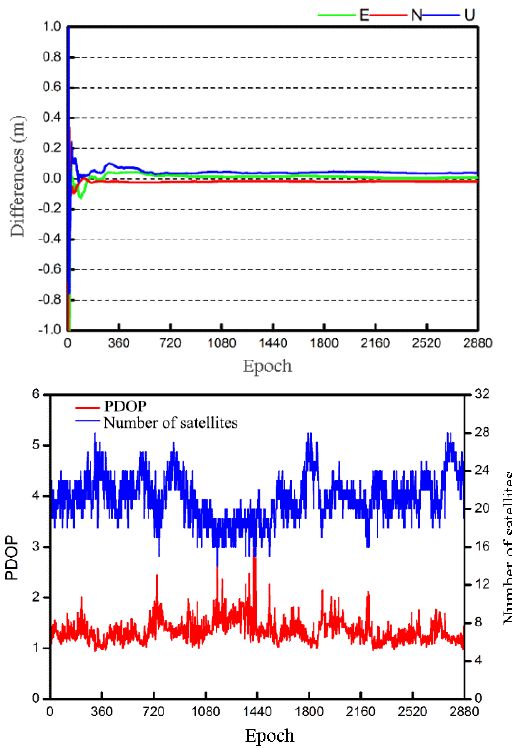
Figure 8. Position deviation and observation of G/R/E/C combined PPP.